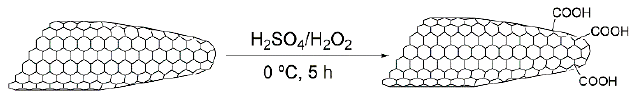
Figure 1. Chemical oxidation of carbon nanohorn (CNH) samples generating carboxylic acid groups.